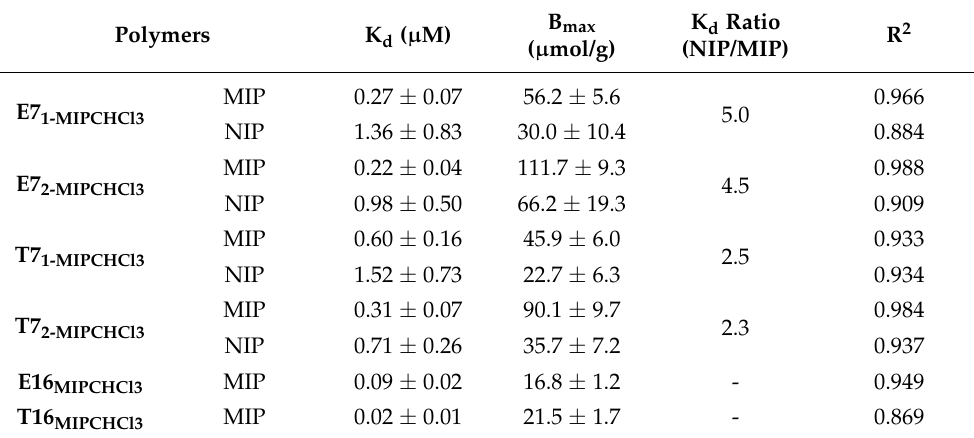
Table 1. Binding and thermodynamic parameters for E 7 1-MIPCHCl3 , E 7 2-MIPCHCl3 , T 7 1-MIPCHCl3 and T 7 2-MIPCHCl3 towards 1